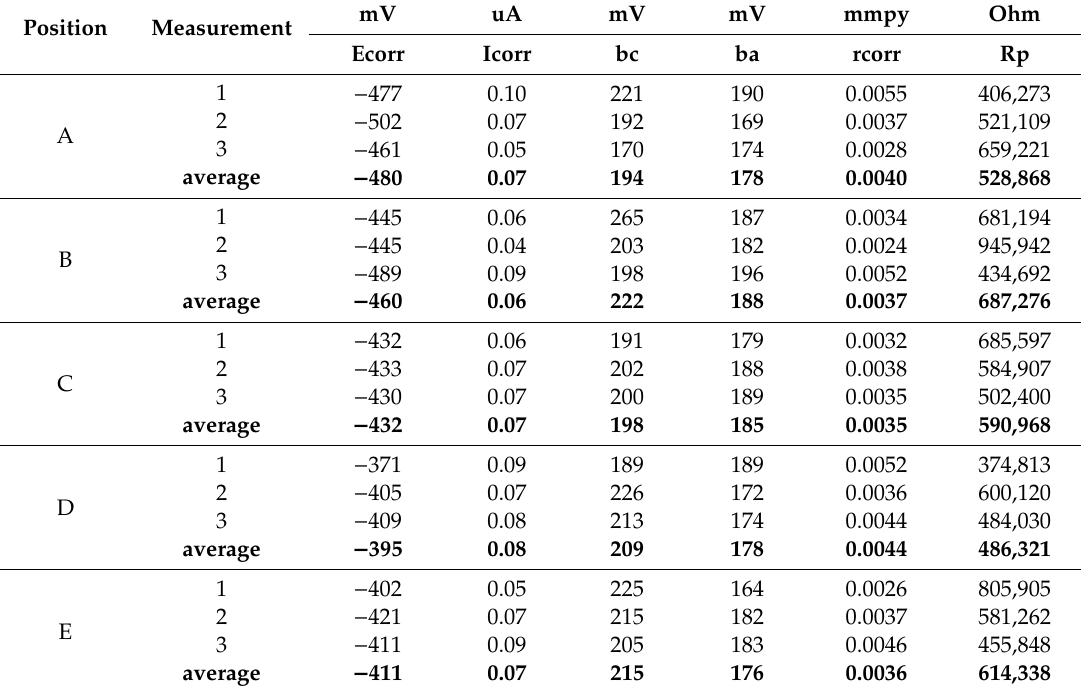
Table 9. Corrosion characteristics of measured